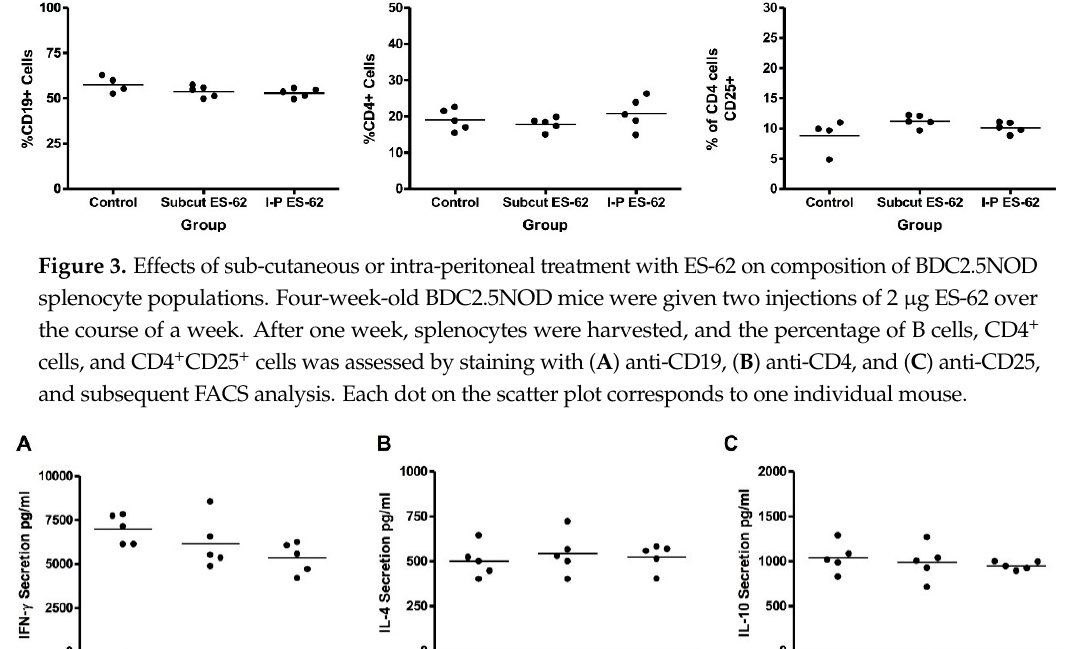
Figure 4. Effects of sub-cutaneous or intra-peritoneal treatment with ES-62 on the ex vivo response of BDC2.5NOD splenocytes to BDC2.5 peptide. Four-week-old BDC2.5NOD mice were given two injections of 2 µ g ES-62 over the course of a week. After one week, splenocytes were harvested. Equal numbers of splenocytes from each group were re-stimulated with 1 mg/mL BDC2.5 peptide. Culture supernatants were harvested at 48 h and assessed for the presence of ( A ) IFN- γ , ( B ) IL-4, and ( C ) IL-10 by ELISA. Each dot on the scatter plot corresponds to the average cytokine secretion of splenocytes from one individual mouse.